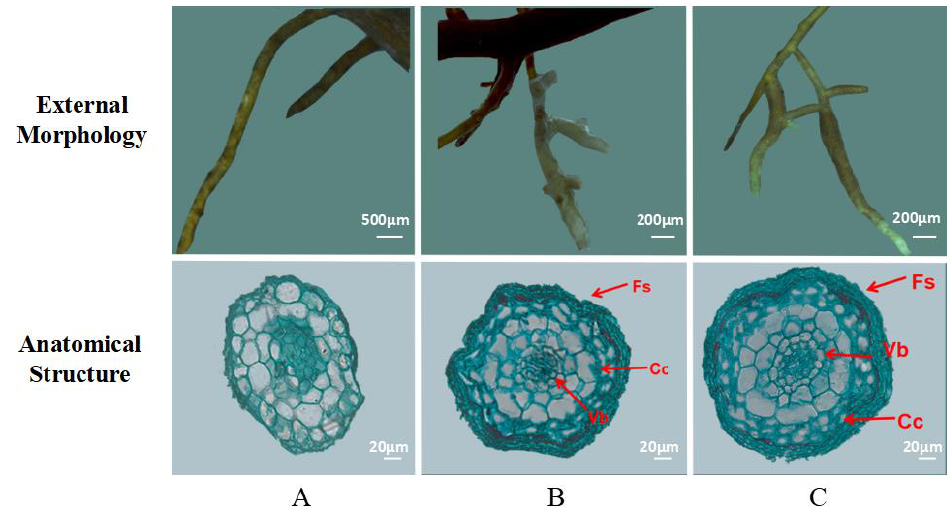
Figure 1. The external morphology and anatomical structure of the mycorrhiza of Q. mongolica . Note: ( A ) control group (non-mycorrhizal roots, no salt stress); ( B ) G. viscidus group; ( C ) S. luteus group. Fs: fungus sheath; Cc: cortical cells; Vb: vascular